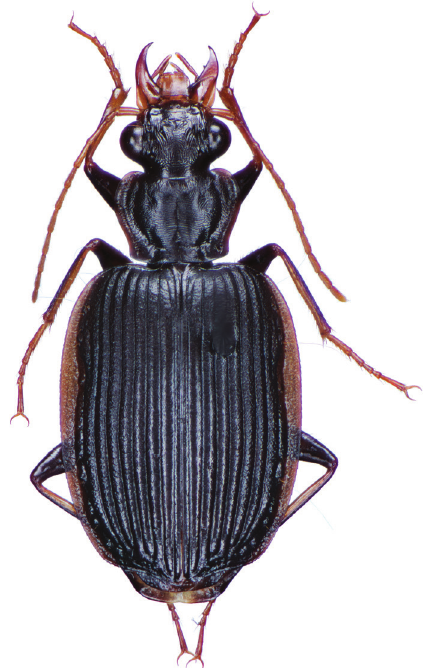
Figure 107. Dorsal habitus and color pattern of Serrimargo schenklingi (Dupuis). (OBL 12.00 mm). elytral disc piceous, margins brunneous to brunneo-piceous; ventral surface of head rufous to rufo-piceous, gula lighter; ventral surface of pronotum, metepisternum and metasternum rufo-piceous; epipleuron of elytra and abdominal sterna lighter, brun- neo-testaceous to brunneous; legs with coxa testaceous to brunneo-testaceous, femora rufo-brunneous to piceous, darker towards apex, tibia with ventral surface testaceous, dorsal surface darker, rufo-piceous to